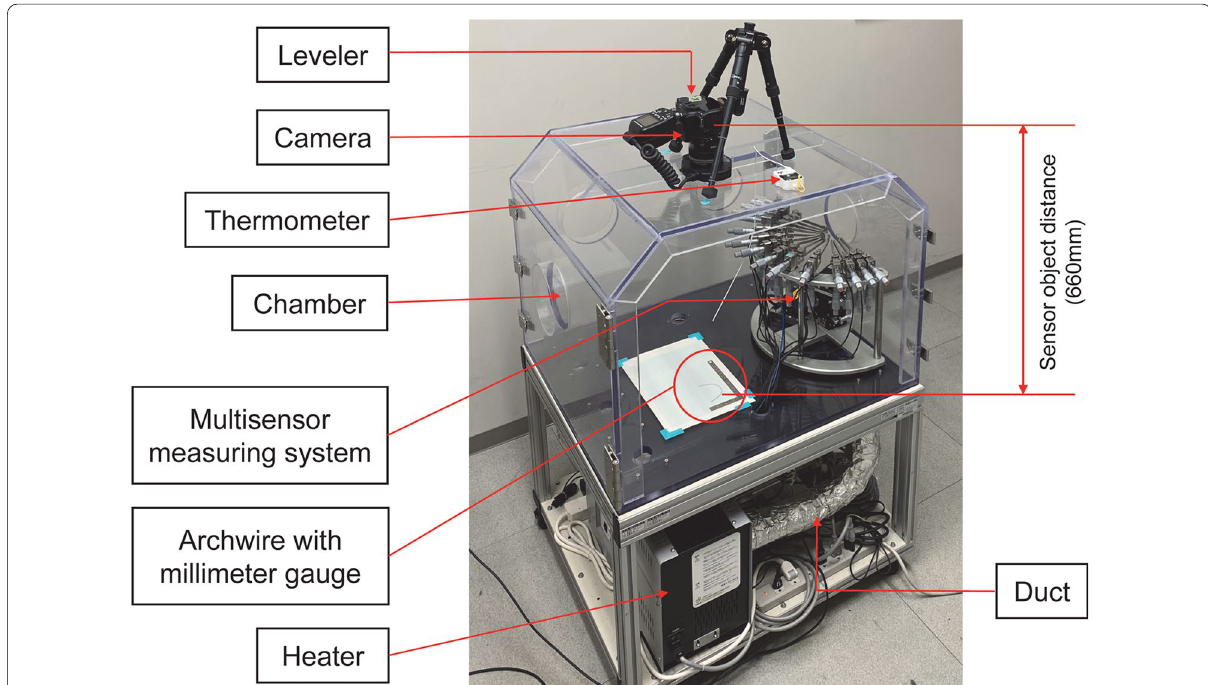
Fig. 1 A camera with a macrolens was fixed, using a leveler to obtain standardized images of the archwires. A millimeter gauge was included in the chamber, which was maintained at 37 °C, as monitored by a thermometer